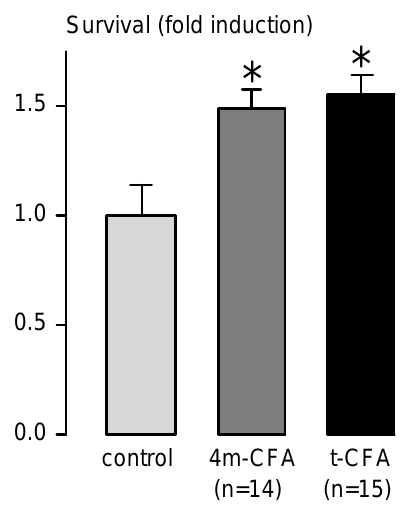
Figure 8. Effect of 4m-CFA (n=14), and t-CFA (n=15) on the survival of cultured CNS neurons. Substances were tested at 100 nM. The data represent means ± SE of three independent experiments. * p <0.05 vs Control; one-way ANOVA, followed by Student-Newman-Keuls